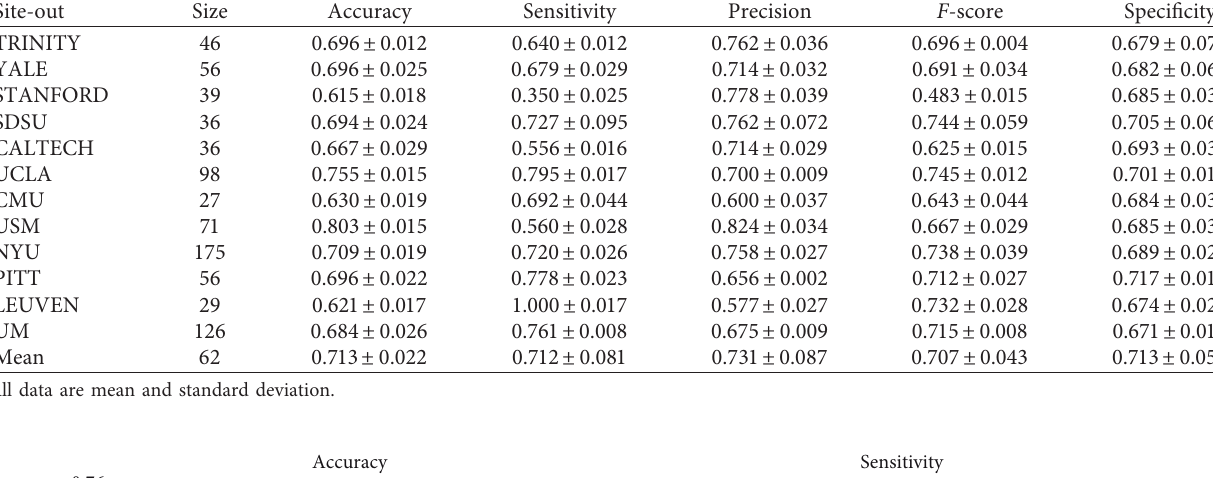
Table 3: Leave-one-site-out cross validation results using multichannel DANN.